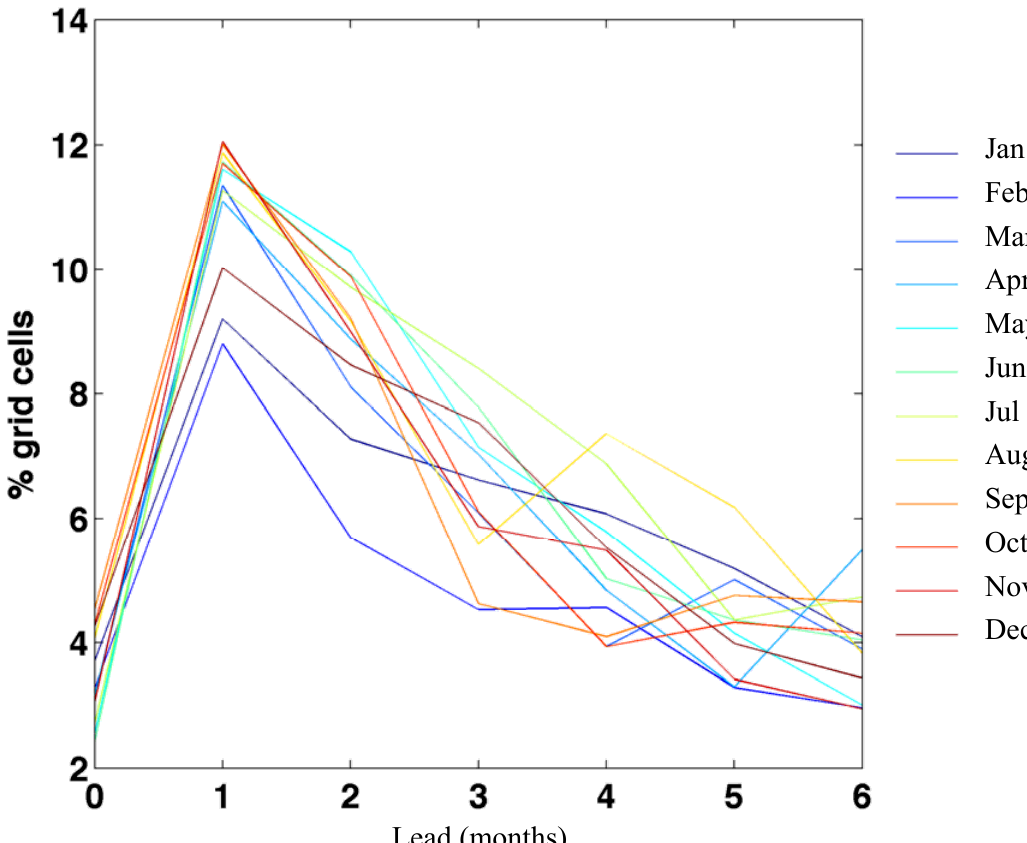
Figure 4. Percentage of land grid cells that show significant ( p < 0.05) positive correlation between GIMMS NDVI and GPCP precipitation anomalies for lead times ranging from 0 to 6 months for 12 months of the year (N = 29, 1982 to 2010). For all 12 months, 1-month lead has the highest land coverage of significant positive NDVI–precipitation